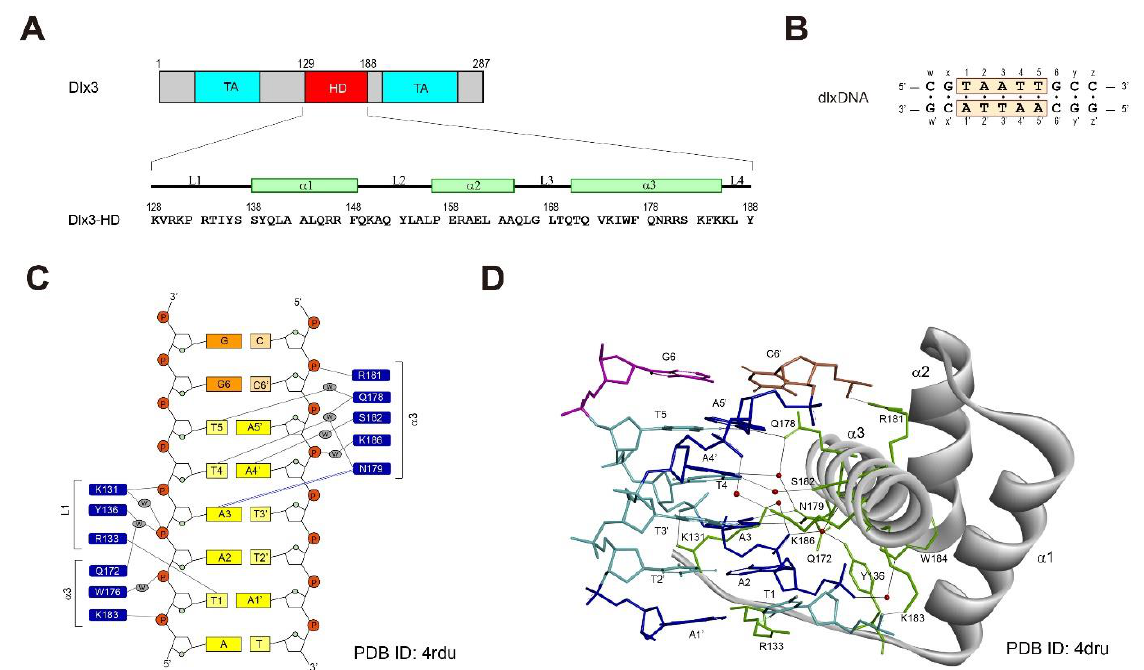
Figure 1. ( A ) Domain structure of Dlx3 and sequence contexts of Dlx3-HD. Numbering and secondary structure elements for Dlx3-HD are shown on top of the sequence. HD and TA indicate homeobox and transactivation domains, respectively. ( B ) Sequence contexts of the dlxDNA duplex. ( C ) Residues of Dlx3-HD involved in intermolecular interaction with DNA reported in previous studies. ( D ) The crystal structure of the Dlx5–DNA complex [21] illustrates intermolecular hydrogen bonding interactions. The red spheres indicate the water molecules involved in water-mediated intermolecular H-bond interactions. The black solid lines indicate the intermolecular H-bond interaction.